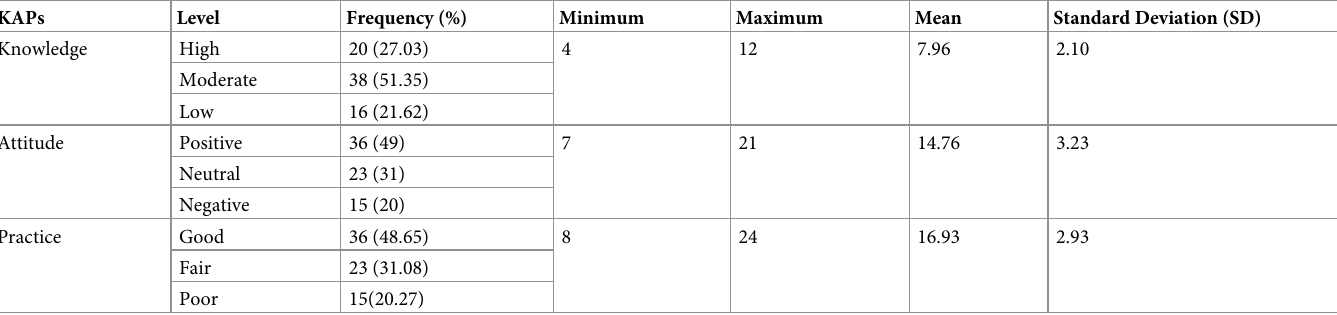
Table 8. The distribution of the farmer’s knowledge, attitudes, and practice on the factors contributing to the occurrence of AMR in dairy farms and personnel.